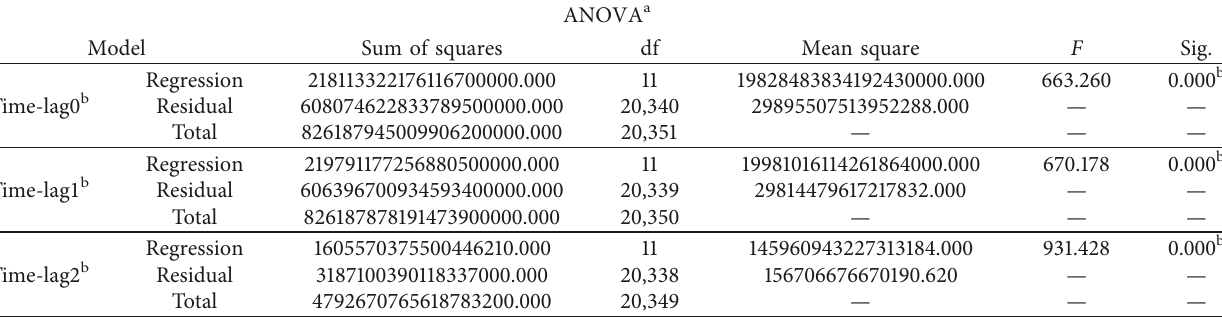
Table 19: ANOVA for a DOE large building depending on